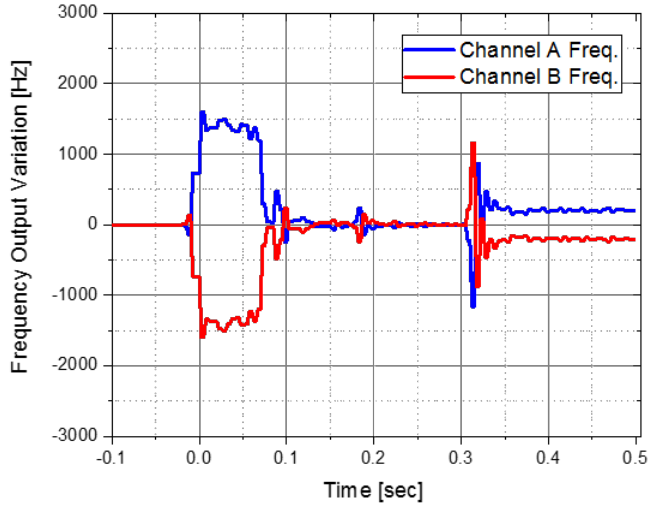
Figure 6. Ideal frequency output for two channels.